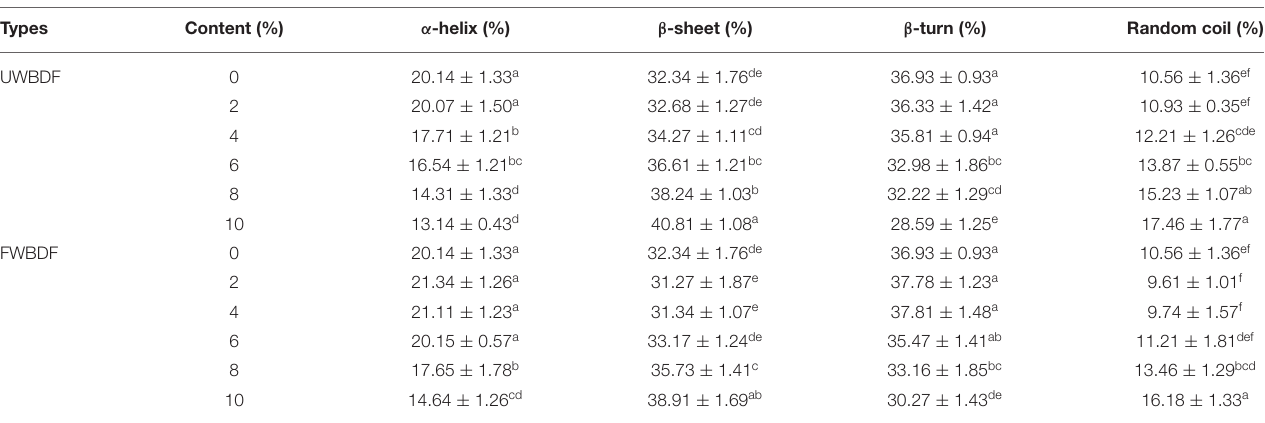
TABLE 1 | Effect of UWBDF/FUWBD addition on the secondary structure of gluten proteins.